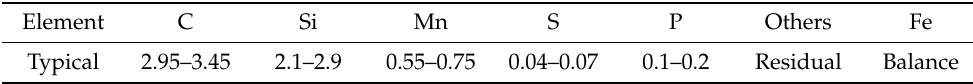
Table 3. Chemical elements table of grey cast iron EN